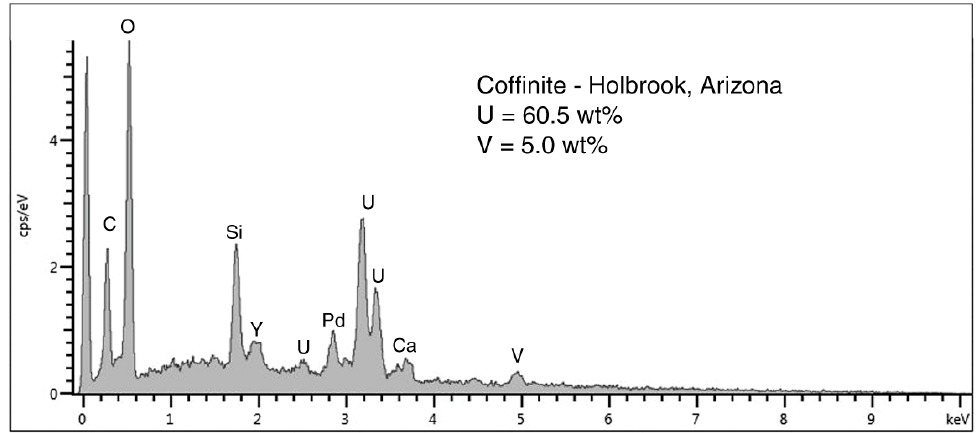
Figure 8. SEM/EDS spectrum of coffinite in the dark gray zone shown in Figure 6. Peak at 0 KeV is detector noise, Pd is coating applied to provide electrical conductivity. The large Si peak probably comes partly from from silicified wood cells, in addition to Si in coffinite, a uranium silicate. Y is a common minor element in uranium ores.